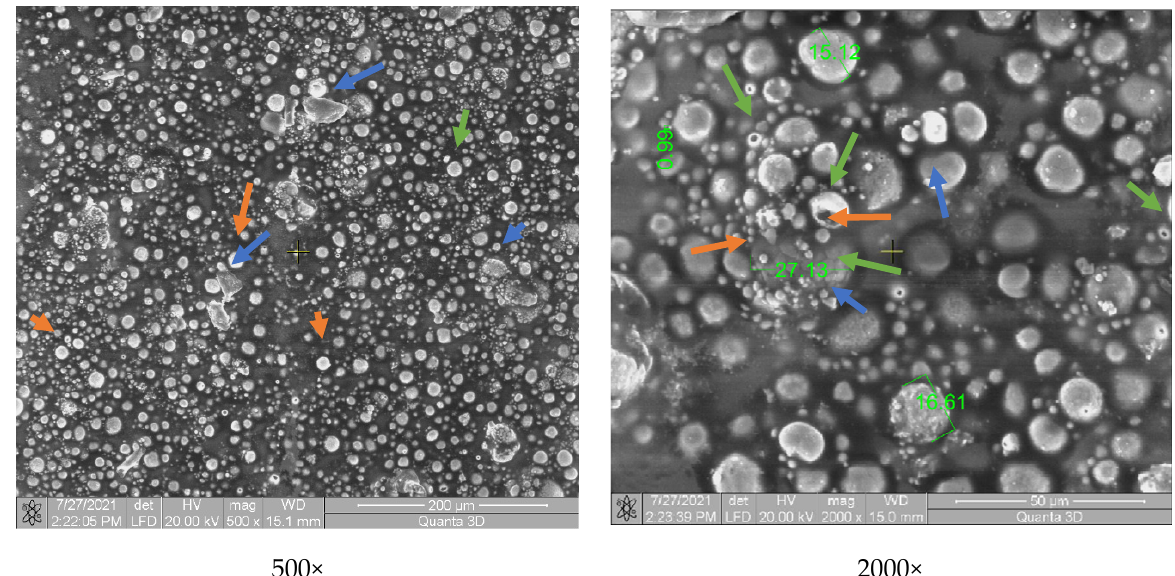
Figure 3. SEM analysis of the P3–143–9 passes samples: Zirconium dioxide (bearing balls)—orange arrow; Titanium dioxide—blue arrow; Yttrium oxide—green arrow.